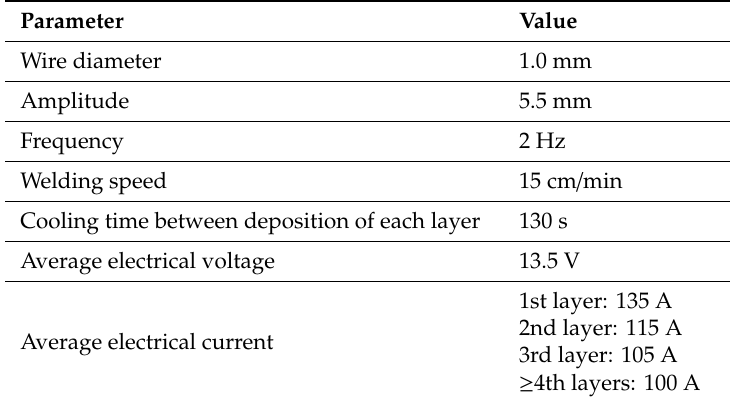
Table 2. WAAM manufacturing